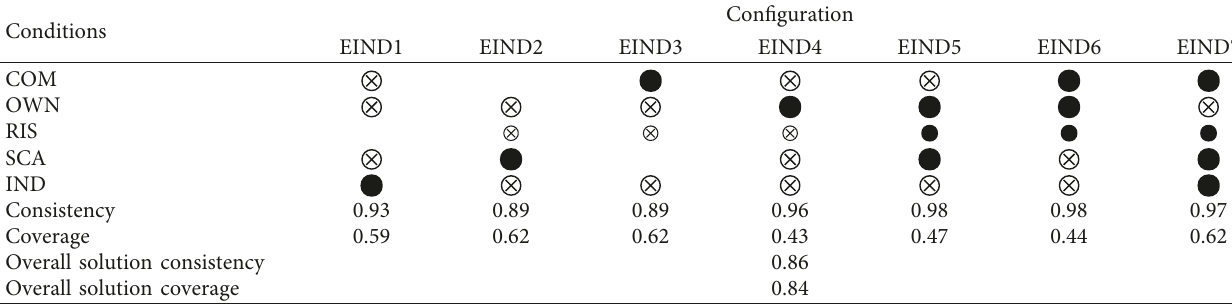
Table 8: The configuration of individual